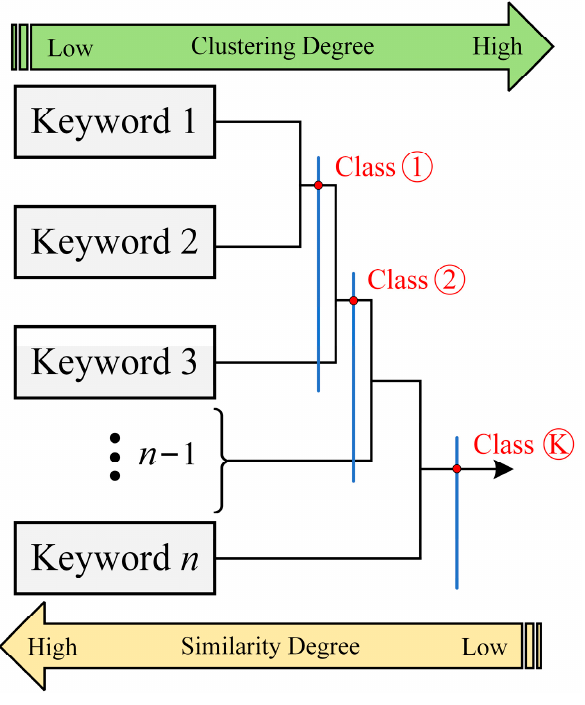
Figure 4. The Principle of Tree Generation.